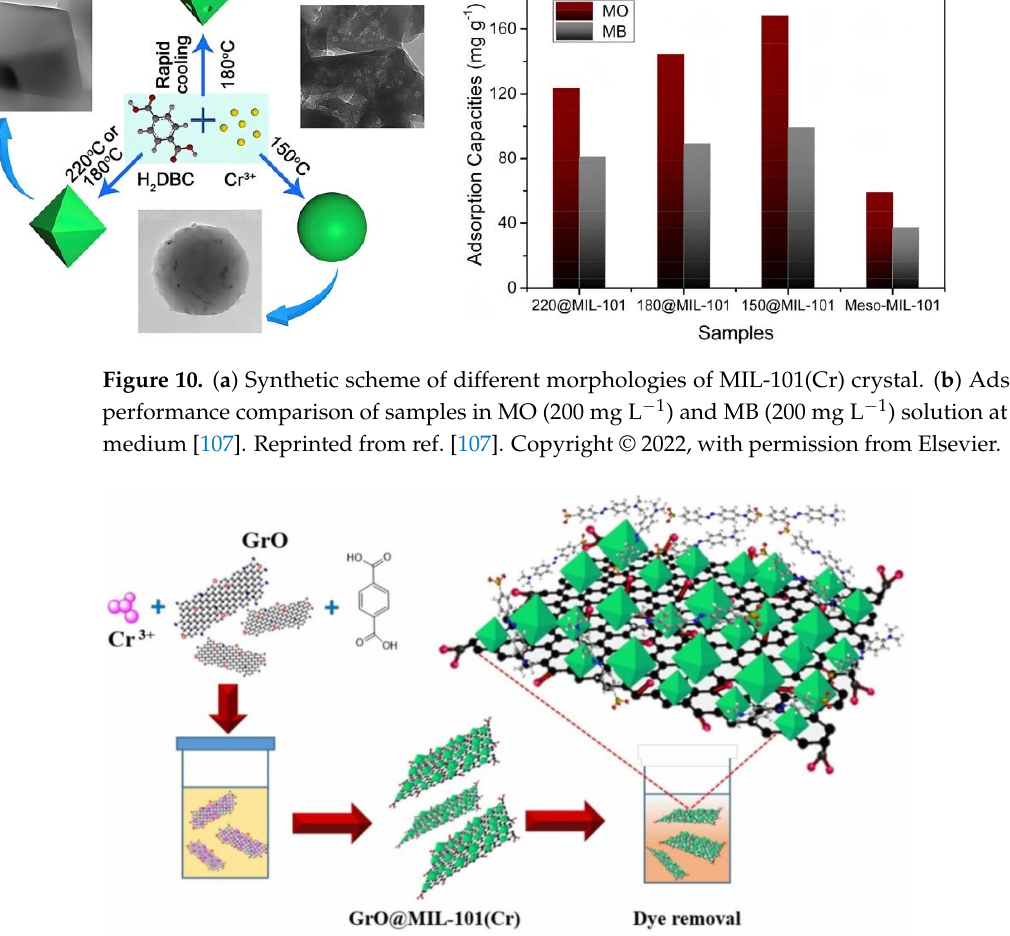
Figure 11. Schematic diagram of CrO/MIL-101 synthesis and dye adsorption [106]. Reprinted from ref. [106]. Copyright © 2022, with permission from